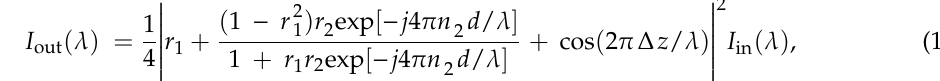
Table 1. The conditions under which the simulations were carried